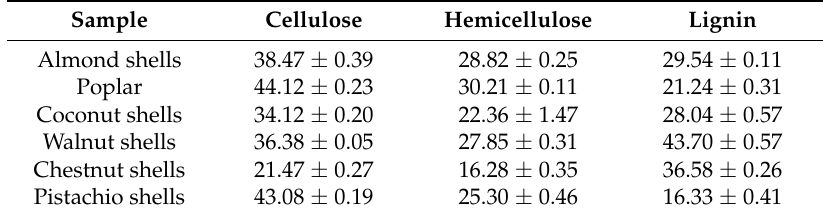
Table 1. Proportion of cellulose, hemicellulose, lignin in six kinds of biomass (wt %). Sample